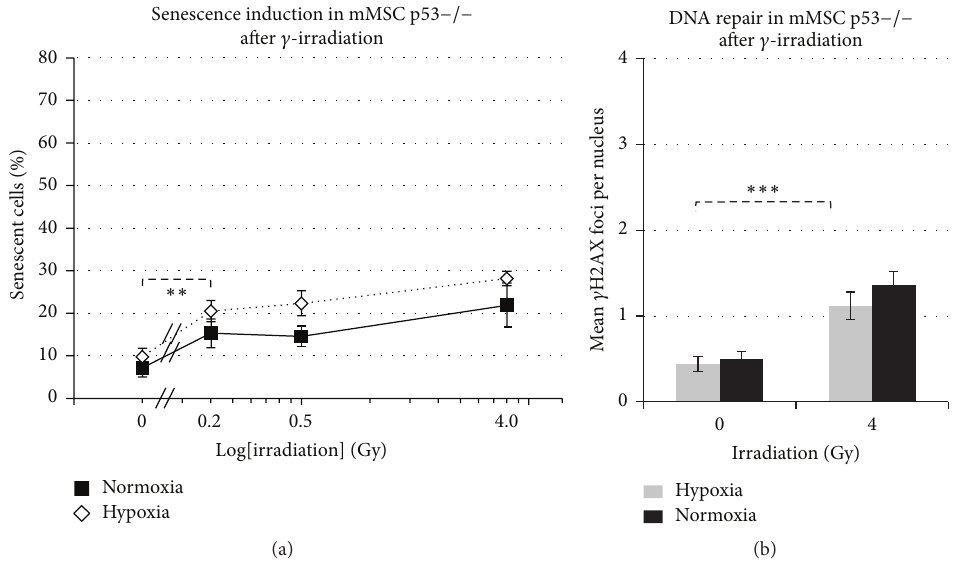
Figure 6: Impact of p53 status on senescence induction and number of DNA repair foci. (a) Graph shows percentage of p53 − / − mMSCs undergoing senescence in hypoxic and normoxic conditions after exposure to 𝛾 -irradiation (sham-irradiated = 0 Gy, 3 biological replicates), radiation dose on logarithmic scale. (b) Quantification of p- 𝛾 H2AX foci in 50 p53 − / − mMSC nuclei depicted as mean values ± standard error of the mean (3 biological